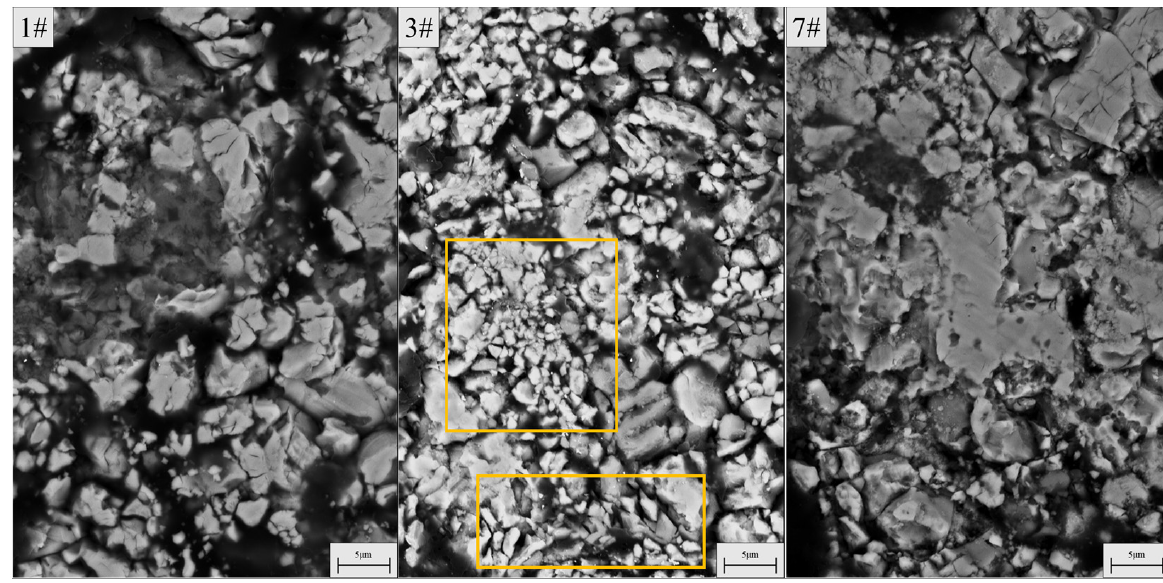
Figure 10. SEM images of the second reduction stage of iron oxides with different basicities.